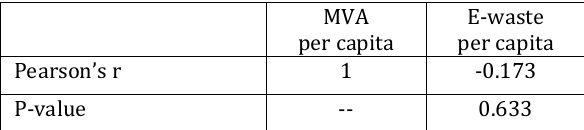
Table 10. Correlation